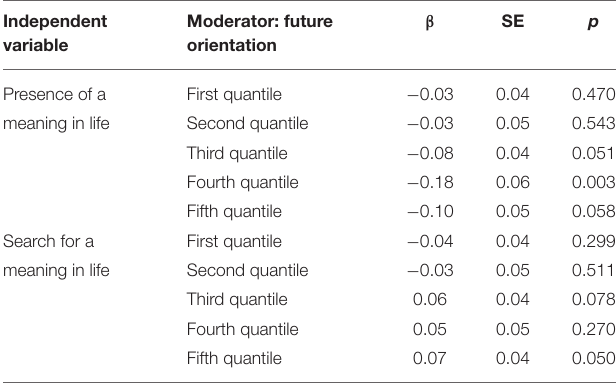
TABLE 5 | Associations between presence of meaning and search for a meaning in life and support for violent radicalization, stratified by levels of future orientation in the overall sample ( n = 3,100).